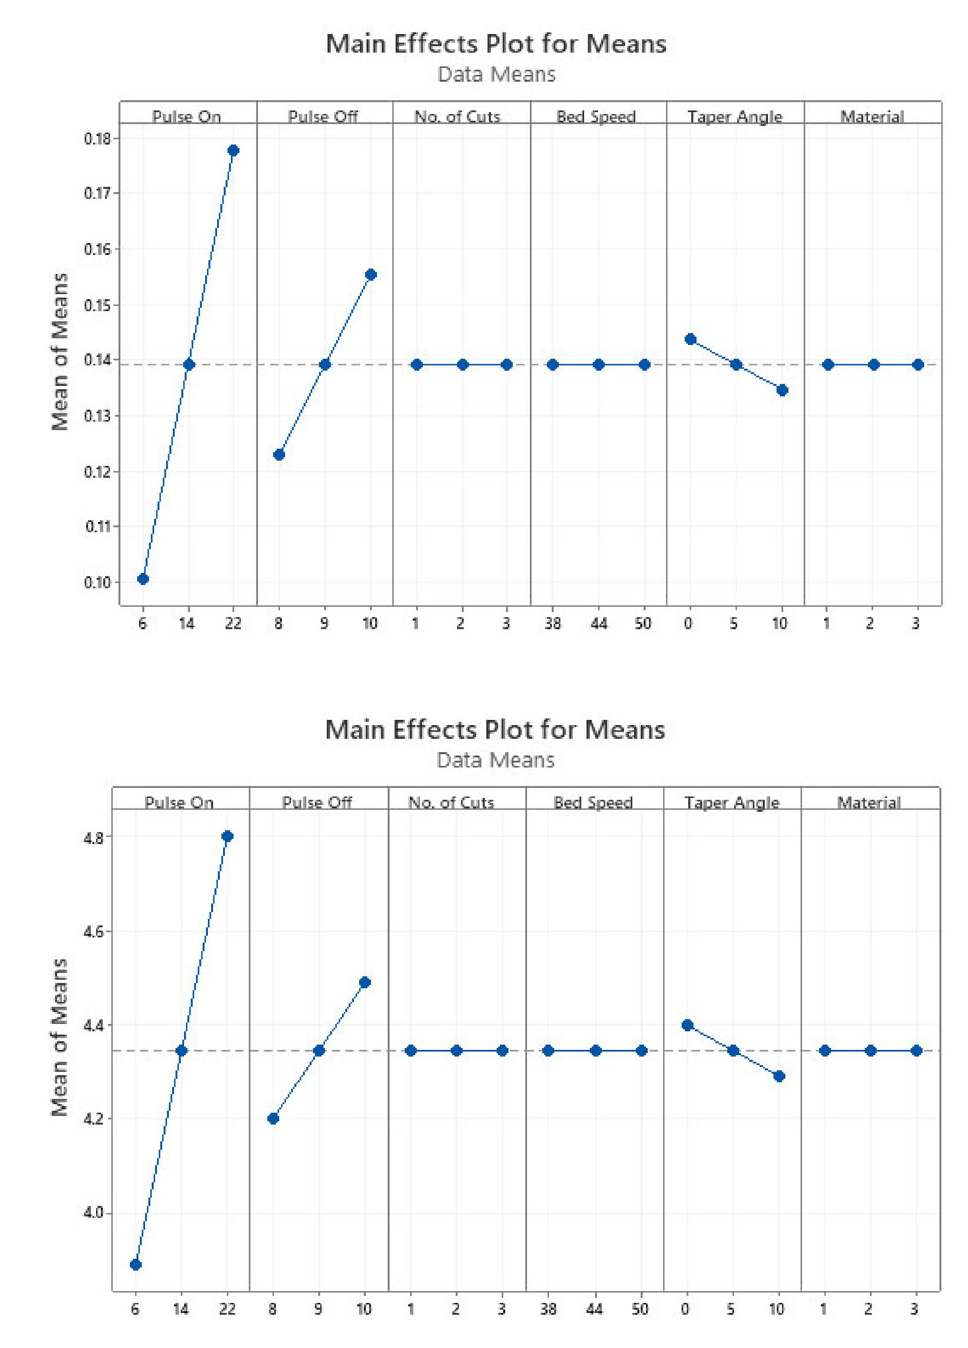
Fig. 12 Main effects plot for means ( MRR )